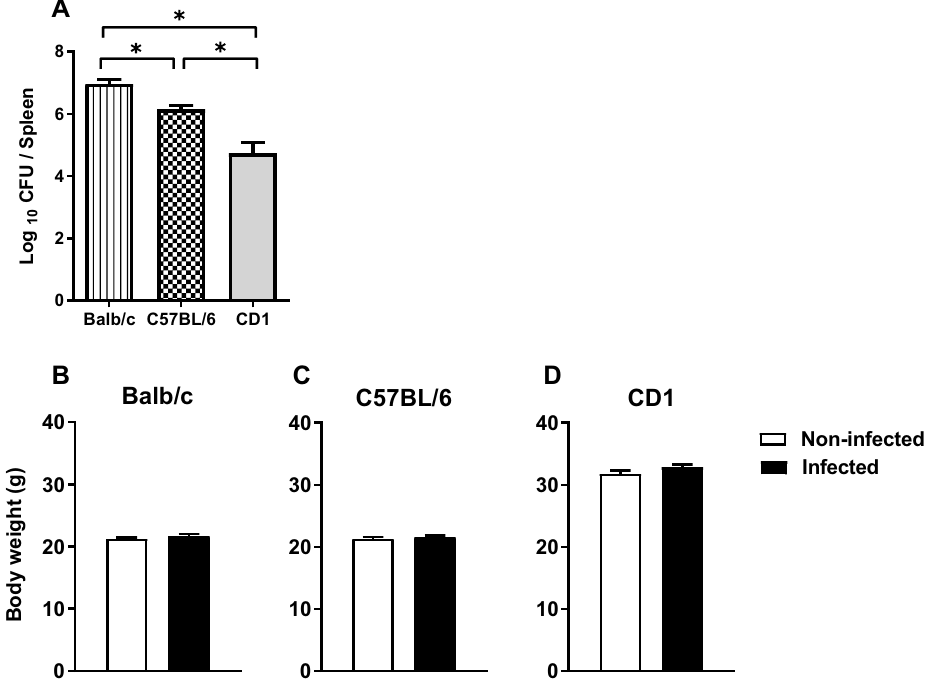
Figure 1. M. avium chronic infection does not alter mice body weight even though different susceptibilities to infection are observed. Spleen bacterial load was determined at 4wpi ( A ). Body weight of Balb/c ( B ), C57BL/6 ( C ) and CD1 ( D ) female mice were assessed in non-infected and 4 weeks infected mice. Each bar represents the mean + SEM of 15–24 mice per group, from 1 of 3 independent experiments. *p <